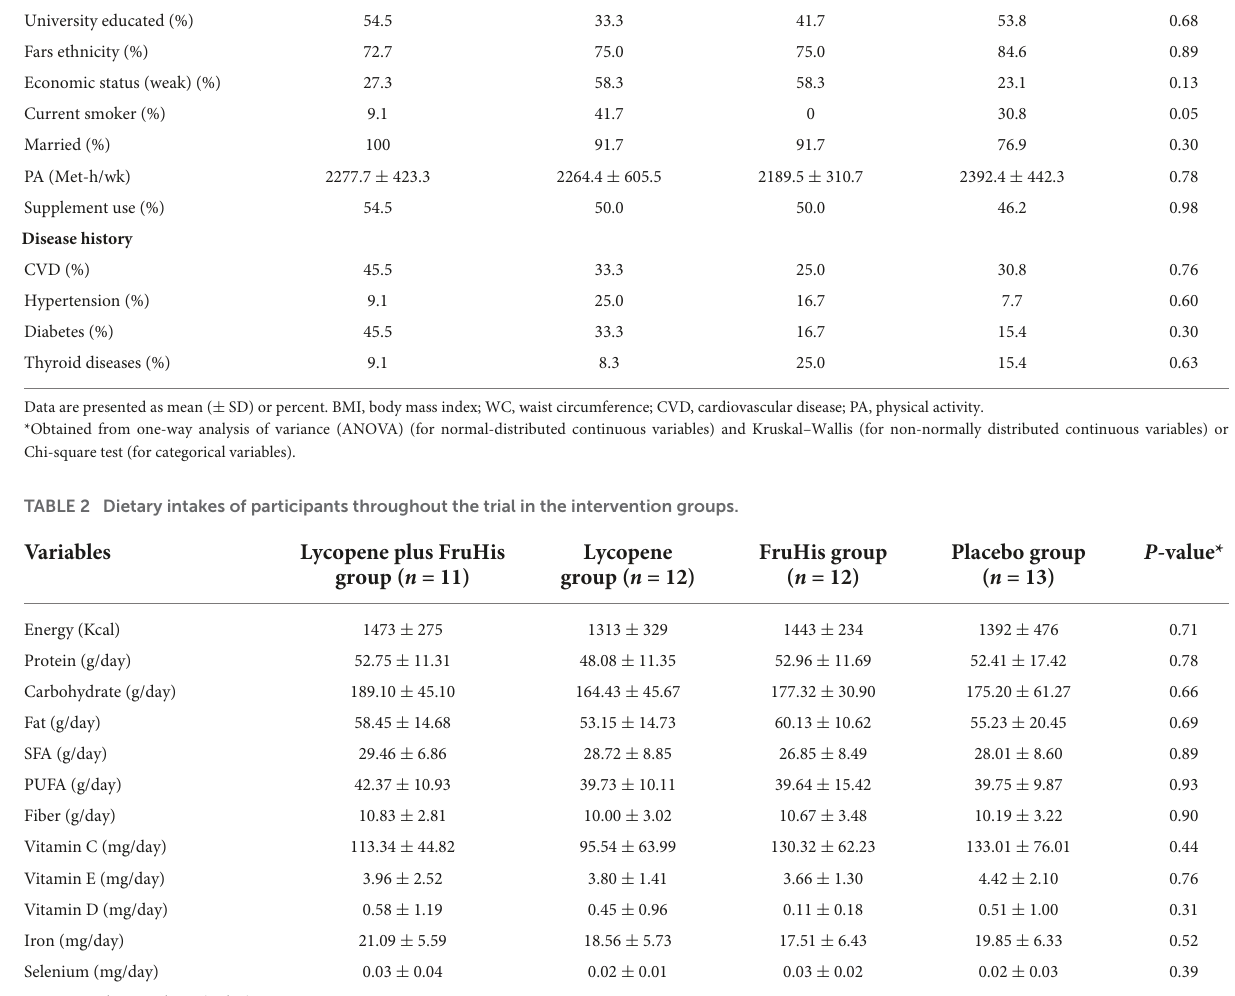
to 18% (-54.47 ± 28.36 ng/mL in the lycopene + FruHis group vs. –30.24 ± 46.69 ng/mL in the lycopene group), on symptom score from 14.5 to 32% (-4.45 ± 4.03 in the lycopene + FruHis group vs. –1.66 ± 5.41 in the lycopene group), on BMI from 0.38 to 2.1% (-0.55 ± 0.90 kg/m 2 in the lycopene + FruHis group vs. –0.10 ± 0.30 kg/m 2 in